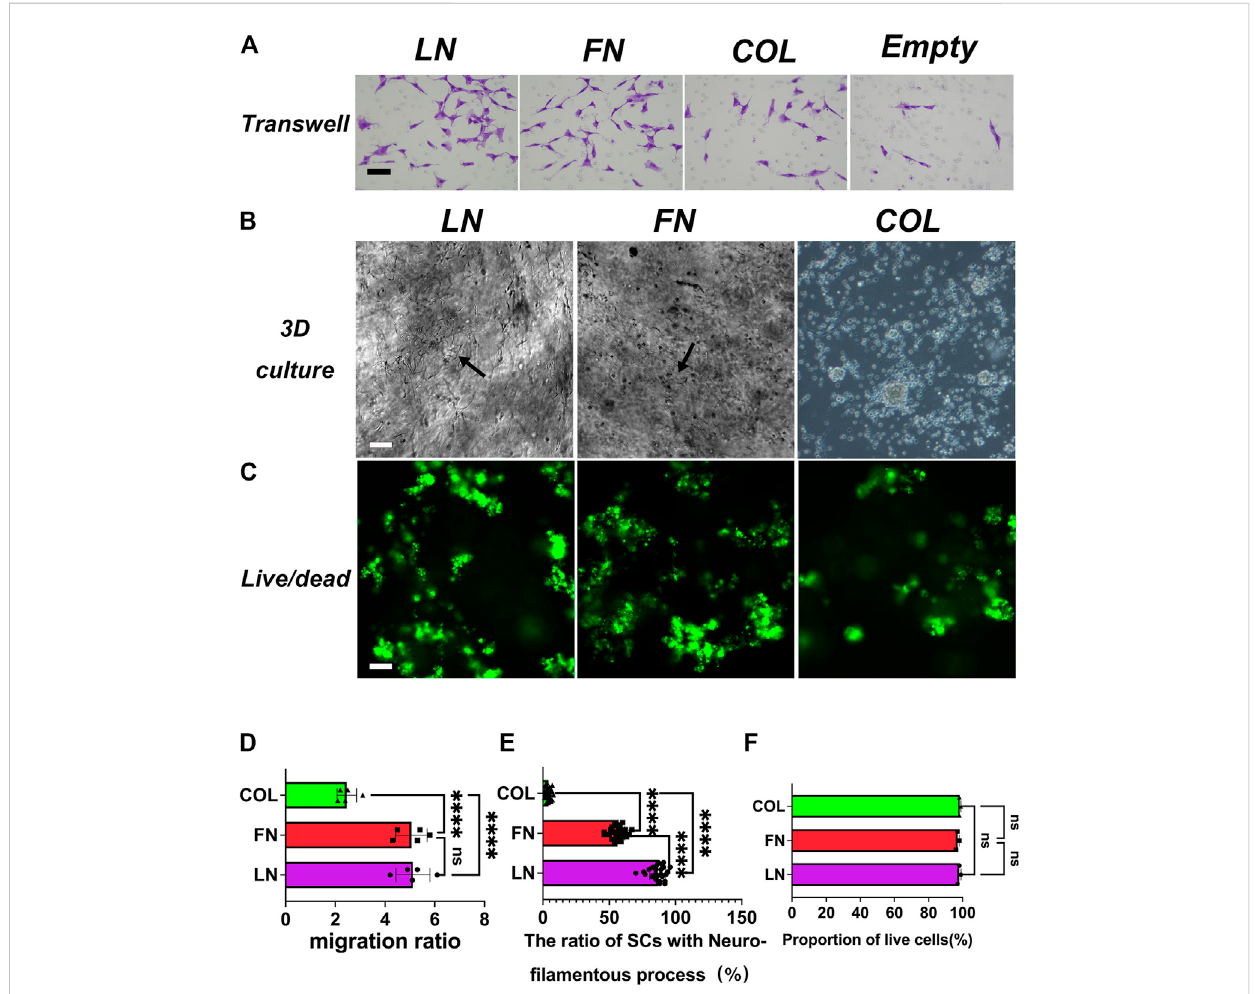
FIGURE 5 Transwell migration assay of SCs and SCs morphology under 3D culture conditions. The results of the transwell experiment showed that the numbers of SCs that migrated in the LN, FN, and IV Col groups were signi fi cantly greater than that in the Control group (A) . Growth conditions of SCs under 3D culture conditions were observed using an optical microscope. Cells in the LN and FN groups showed good cell morphology, with elongated processes (black arrows), and cells in the type IV Col group showed mass-like aggregation (B) . Live/dead staining analysis of live cells (green)/dead cells(red)ineachgroup (C) .Quantitativeanalysisofcellmigration(numberofcellsintheControlgroupwastakenasreferencevalue1)[ (D) , n =5]:theLN groupandFNgrouphadsimilarrelativecellmigrationnumbers( p > 0.05),andbothweresigni fi cantlymorethanthatinthetypeIVColgroup( p < 0.0001). TheproportionofSCs with fi lamentous processes among thetotalnumber ofcells wasassedunder3Dcultureconditions [ (E) , n = 25].Theproportionof SCs with fi lamentous processes in the LN group was signi fi cantly higher than that in the FN group and type IV Col groups ( p < 0.0001). Cell survival was assessed [ (F) , n =3].Theproportionofviablecells intheLNgroup, FNgroupandtypeIVColgroupwassimilar( p > 0.05).**** p < 0.0001, ns p > 0.05. Scale bar = 100